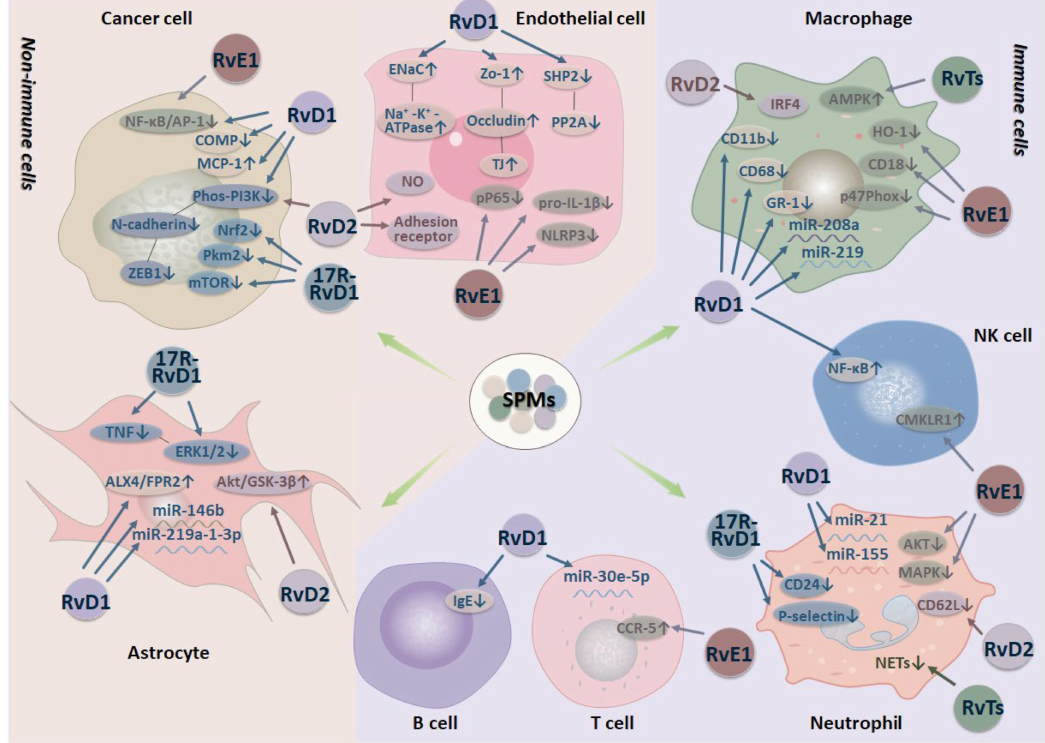
Figure 2. Different actions of resolvins on several target